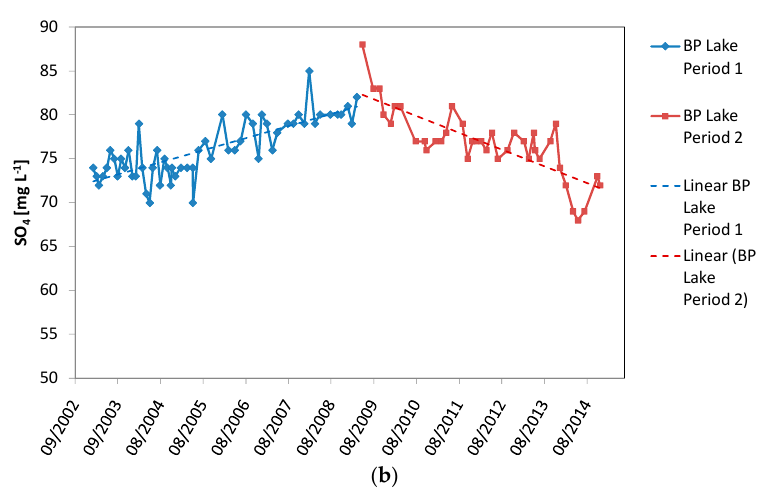
Figure 10. ( a ) SO 4 concentration of gravel pit lake with artificial recharge (DLV Lake), groundwater fed only (BP Lake) and Meuse River from 2002 to 2014; ( b ) SO 4 concentration in BP Lake, divided into two periods with linear regression lines.